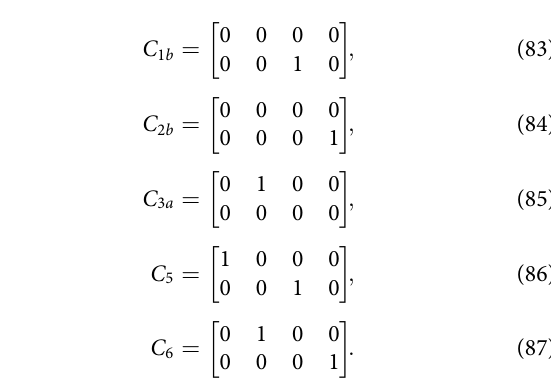
FIGURE 20 | Position estimates (first and third states of the process) of the active-passive sensor network in Example 5 with 13 nodes under the proposed architecture equations (58) and (59) and satisfying the linear matrix inequalities equations (60) and (61) (the dash line denote the trajectory of the actual process (i.e., the combination of the first and third states) and the solid lines denote the state estimates of nodes). Here, AN stands for the active